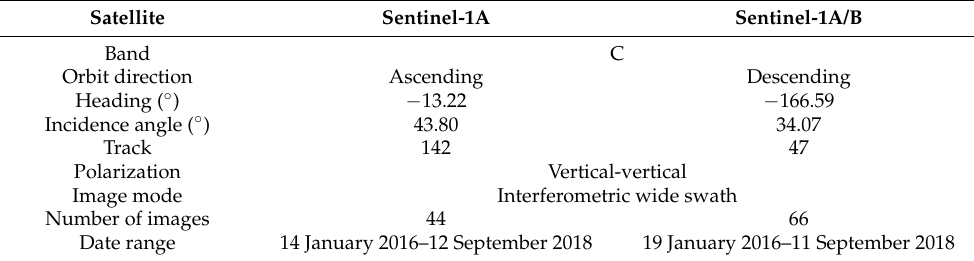
Table 3. Satellite information for the data used in this